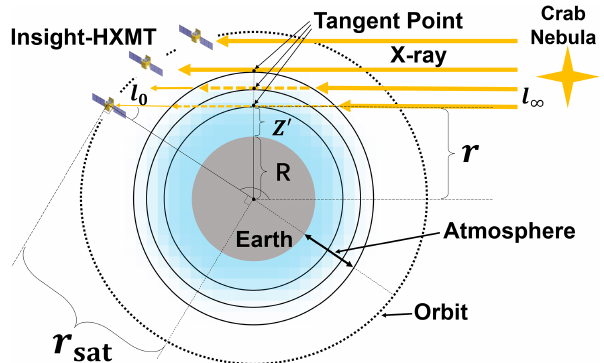
Figure 1. The observation geometry of the X-ray Earth occultation of the Crab Nebula with Insight-HXMT. Tangent point altitude ( Z (cid:48) ) is the shortest distance from the Earth’s surface to the line of sight. The line of sight is defined as the line from the satellite position l 0 to the X-ray source position l ∞ . r sat is the distance from the satellite to the centre of the Earth. r is the distance from the tangent point to the centre of the Earth. R is the radius of the Earth. The dotted line shows the satellite orbit. The extent of the atmosphere is marked by a double-sided arrow. The location of the tangent point is marked. The Insight-HXMT and the Crab Nebula are also marked. For clar- ity, only three layers of the atmosphere are marked, as shown by the solid black lines. The thick, solid orange lines with arrows show the X-rays before absorption and scattering. The dashed orange lines with arrows show the absorption and scattering of X-rays by the atmosphere. The thin, solid orange lines with arrows show X-rays passing through the atmosphere.